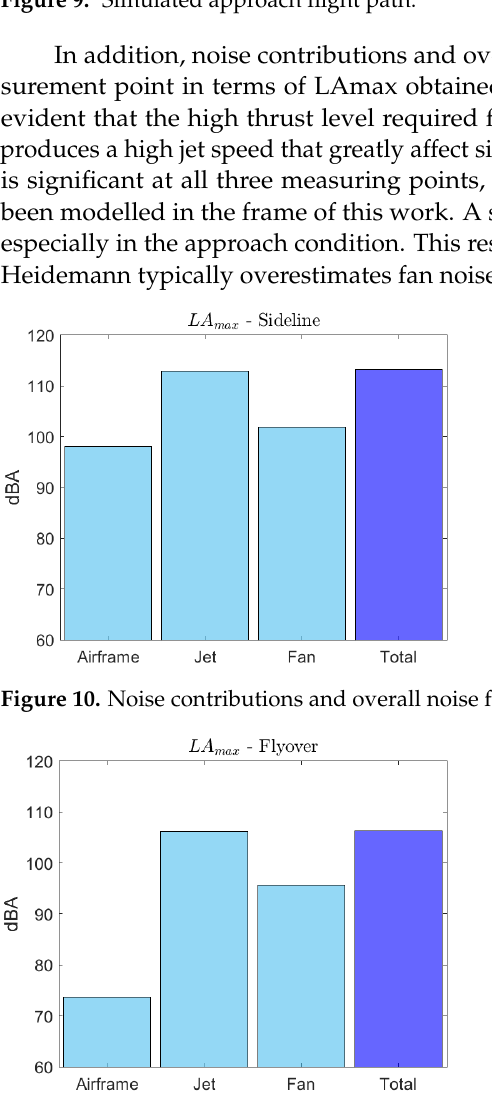
Figure 11. Noise contributions and overall noise for flyover measurement